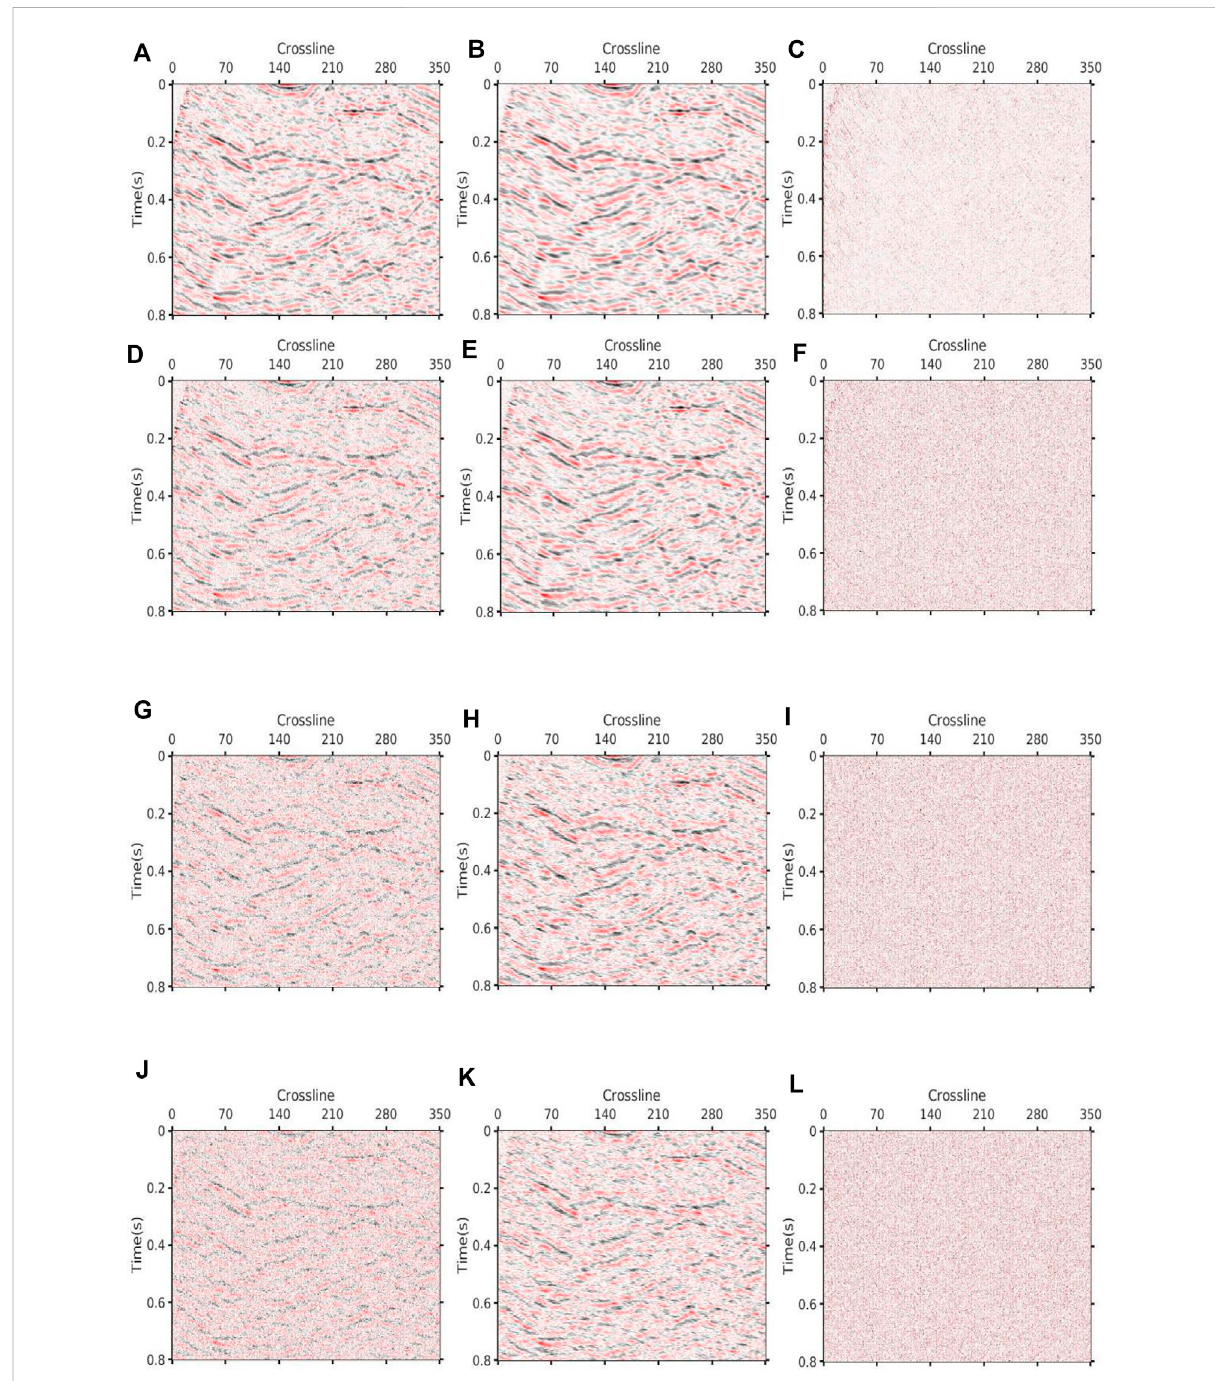
FIGURE 19 DCT+K-SVD denoising results via different levels of noise. (A) Image with 20 Hz noise (SNR=6.99 dB PSNR=23.34 dB). (B) Denoised data via 20 Hz noise (SNR=9.65 dB PSNR=25.99 dB). (C) Removed noise via 20 Hz noise. (D) Image with 35 Hz noise (SNR=0.96 dB PSNR=17.31 dB). (E) Denoised data via 35 Hz noise (SNR=5.9 dB PSNR=22.24 dB). (F) Removed noise via 35 Hz noise. (G) Image with 50 Hz noise (SNR= − 3.88 dB PSNR=12.46 dB). (H) Denoised data via 50 Hz noise (SNR=1.94 dB PSNR=18.29 dB). (I) Removed noise via 50 Hz noise. (J) Image with 65 Hz noise (SNR= − 6.98 dB PSNR=9.36 dB). (K) Denoised data via 65 Hz noise (SNR= − 0.25 dB PSNR=16.09 dB). (L) Removed noise via 65 Hz